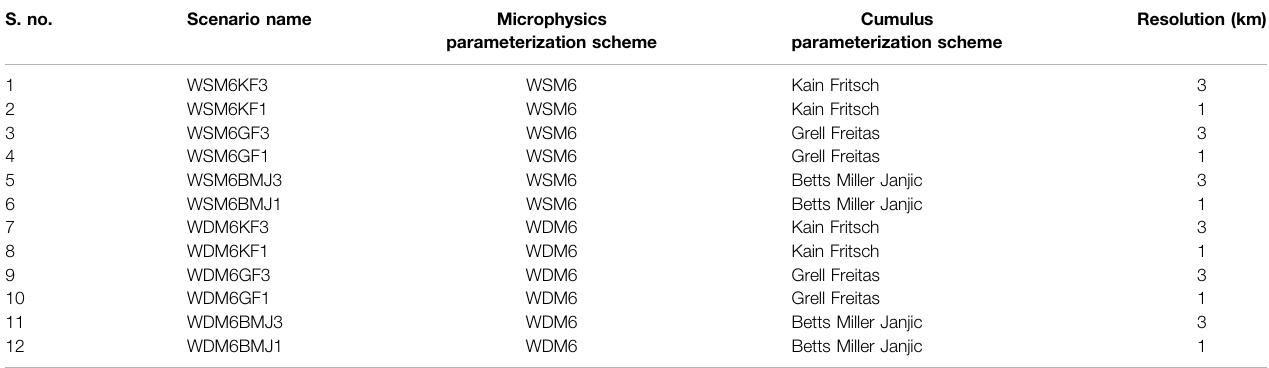
TABLE 2 | List of physics combinations for the 12-member WRF ensemble. S. no.